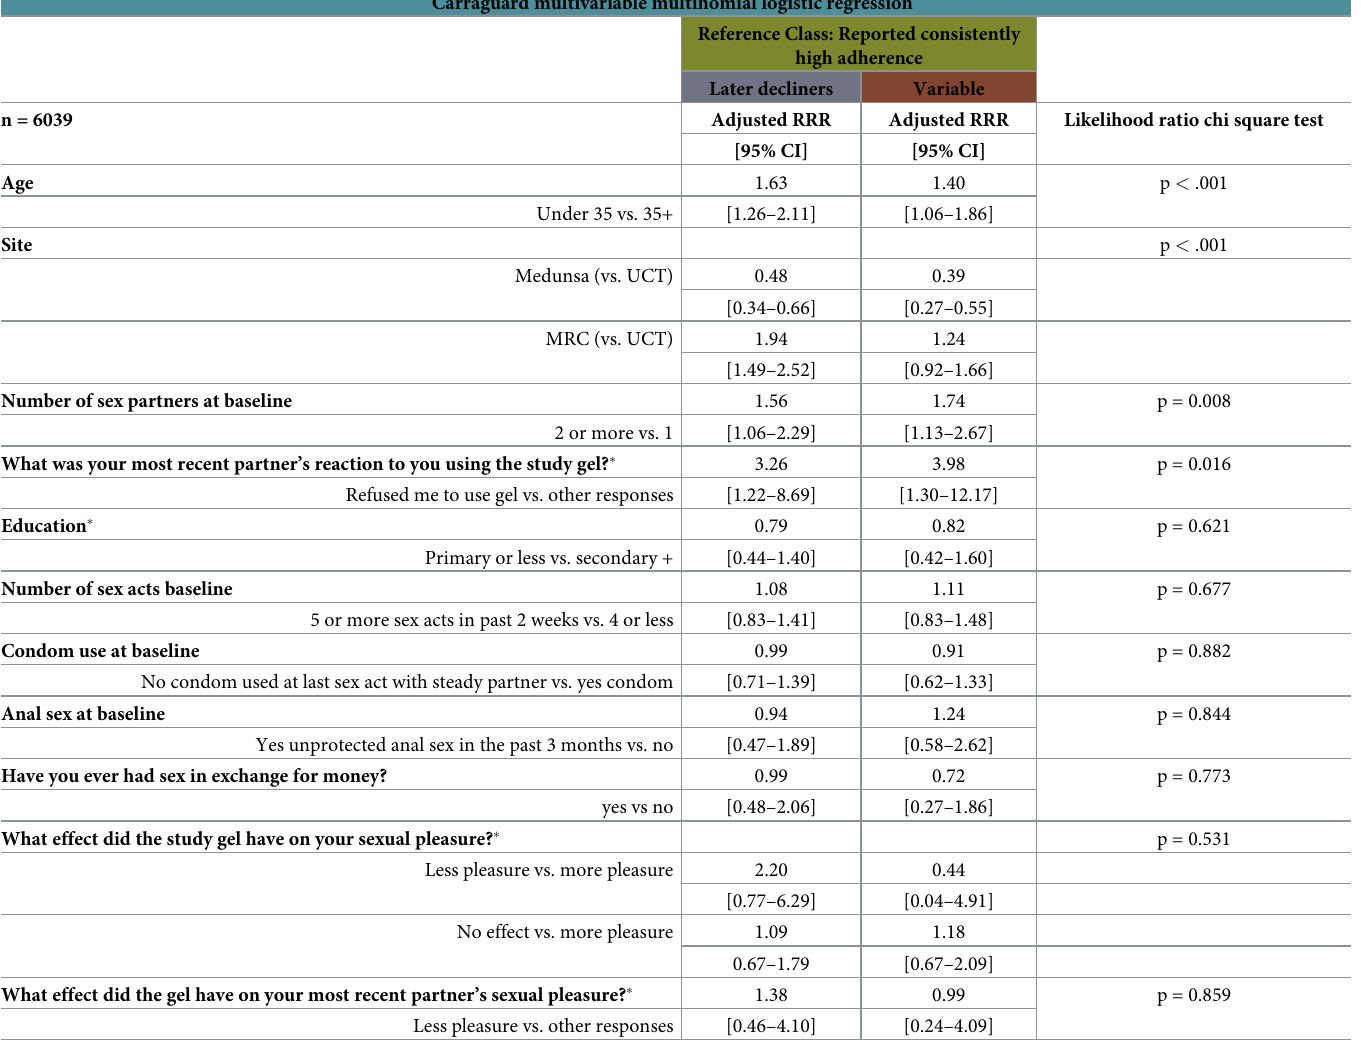
Table 4. Carraguard multivariable multinomial logistic regression. Carraguard multivariable multinomial logistic